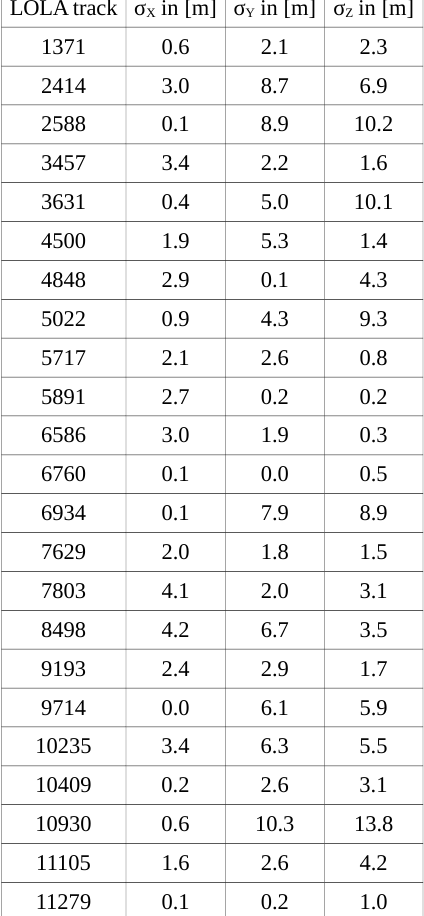
Table 2: Standard deviations (in X,Y,Z) of the nominal LOLA tracks covering the Mons Esam region. After the optimal absolute position of the NAC DTM has been determined, the nominal (measured) LOLA profiles are shifted to accurately match the NAC DTM. The shifted LOLA shots are then assigned to the appropriate photogrammetric object points derived by ray intersection and are thus simultaneously correlated with the corresponding tie points in image space. At the same time, the information about LOLA’s nominal, measured 3D coordinates are preserved to later use them